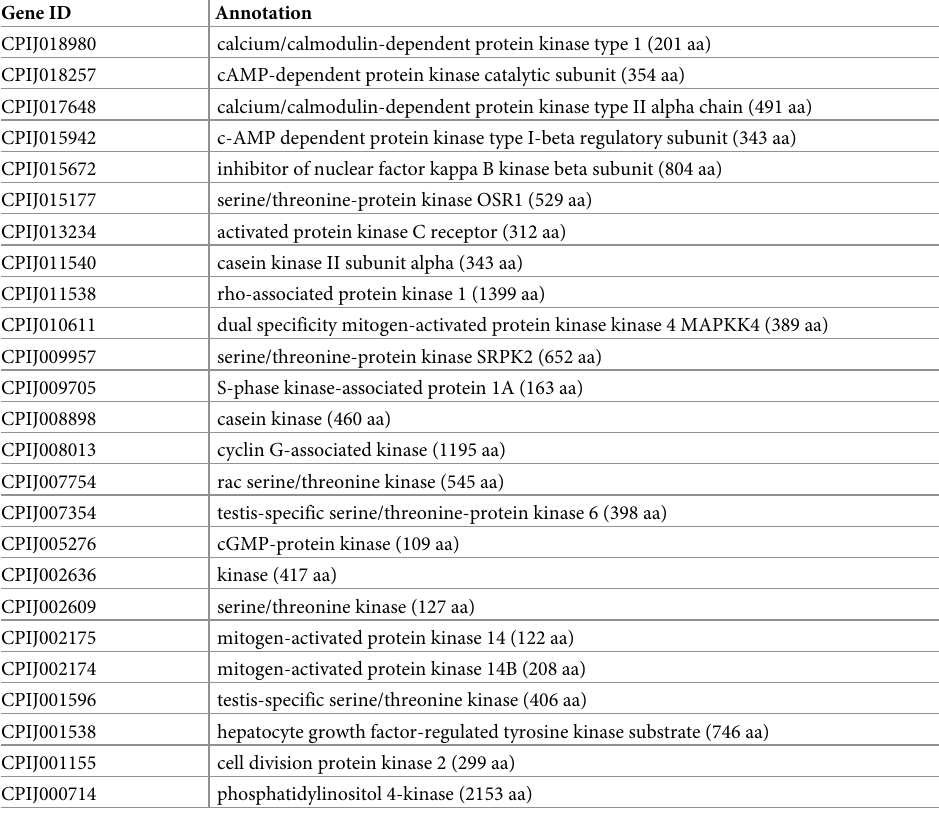
Table 1. Non-metabolic kinases and associated regulatory subunits detected in the Culex sperm